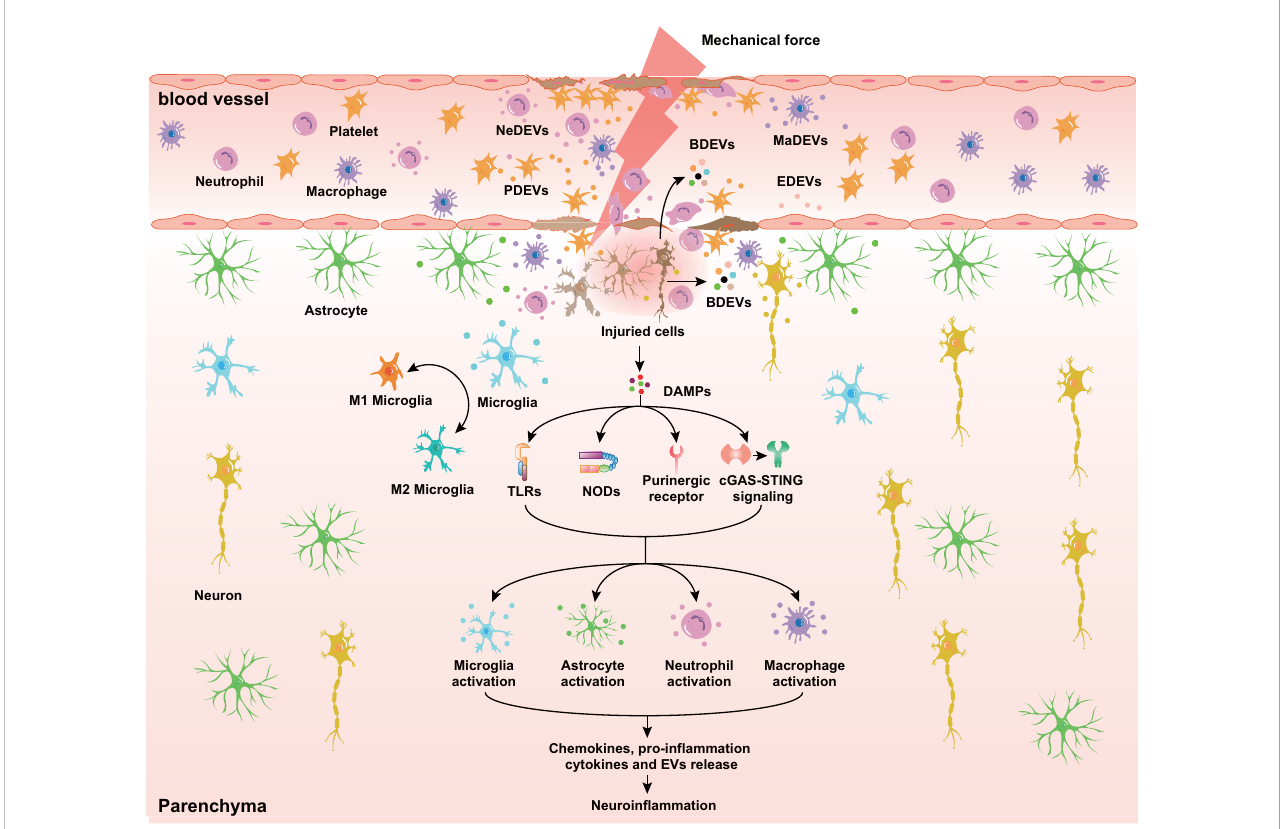
FIGURE 1 Diverse EVs released in response to TBI. At the acute stage of TBI, BDEVs, including neuron-, microglia cell-, and astrocyte-derived EVs, are released into the lesion area and peripheral circulation through the disrupted BBB. Endothelial cells, immune cells (neutrophils and macrophages), and platelets release EVs in response to mechanical force and secondary injuries. Additionally, DAMPs released from dying neurons interact with prominent receptors such as TLRs, NODs, and purinergic receptors and initiate the secretion of cytokines, chemokines, and EVs in microglia, astrocytes, and immune cells. NeDEVs, Neutrophil-derived extracellular vesicles; BDEVs, Brain derived extracellular vesicles; PDEVs, Platelet-derived extracellular vesicles; MaDEVs, Macrophage- derived extracellular vesicles; EDEVs, Endothelial cell-derived extracellular vesicles; DAMPs, Damage associated molecular patterns; BBB, Blood-brain barrier; TLRs, Toll-like receptors; NODs, Nucleotide-binding oligomerization